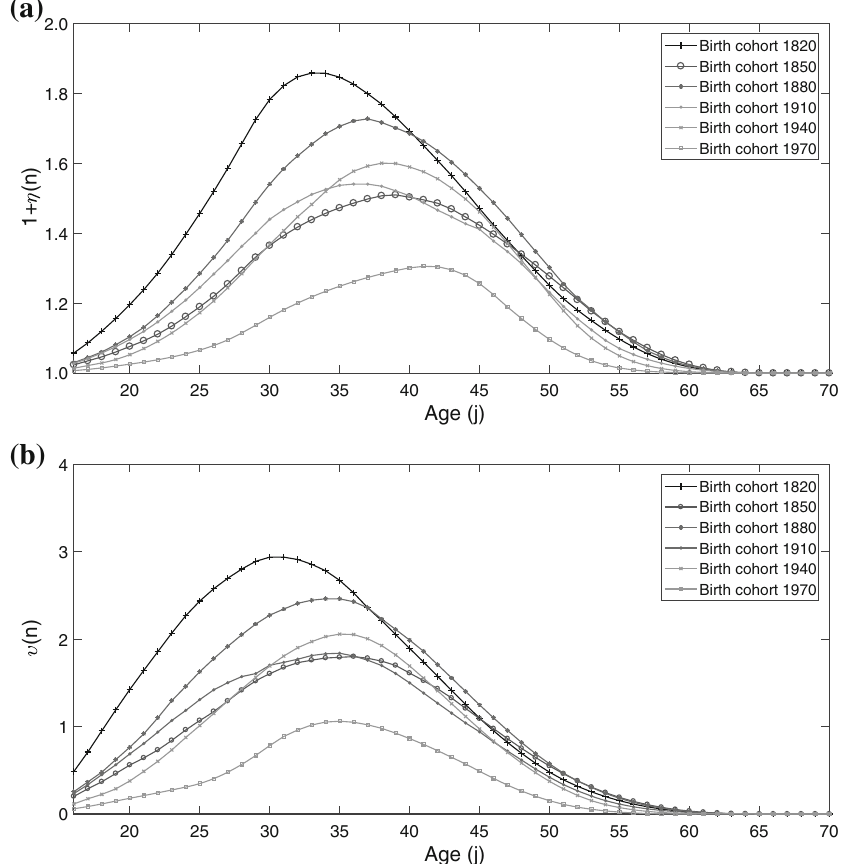
Fig. 3 Number of equivalent adults consumers and time spent rearing children per hour of household chores for selected birth cohort. a Equivalent adult consumers, 1 + η( n ) , b time spent rearing children per hour of household chores, υ( n ) . Source Authors’ estimates based on the population reconstruction and AGENTA data. Note: Profiles calculated under the assumption that children leave the parental house at